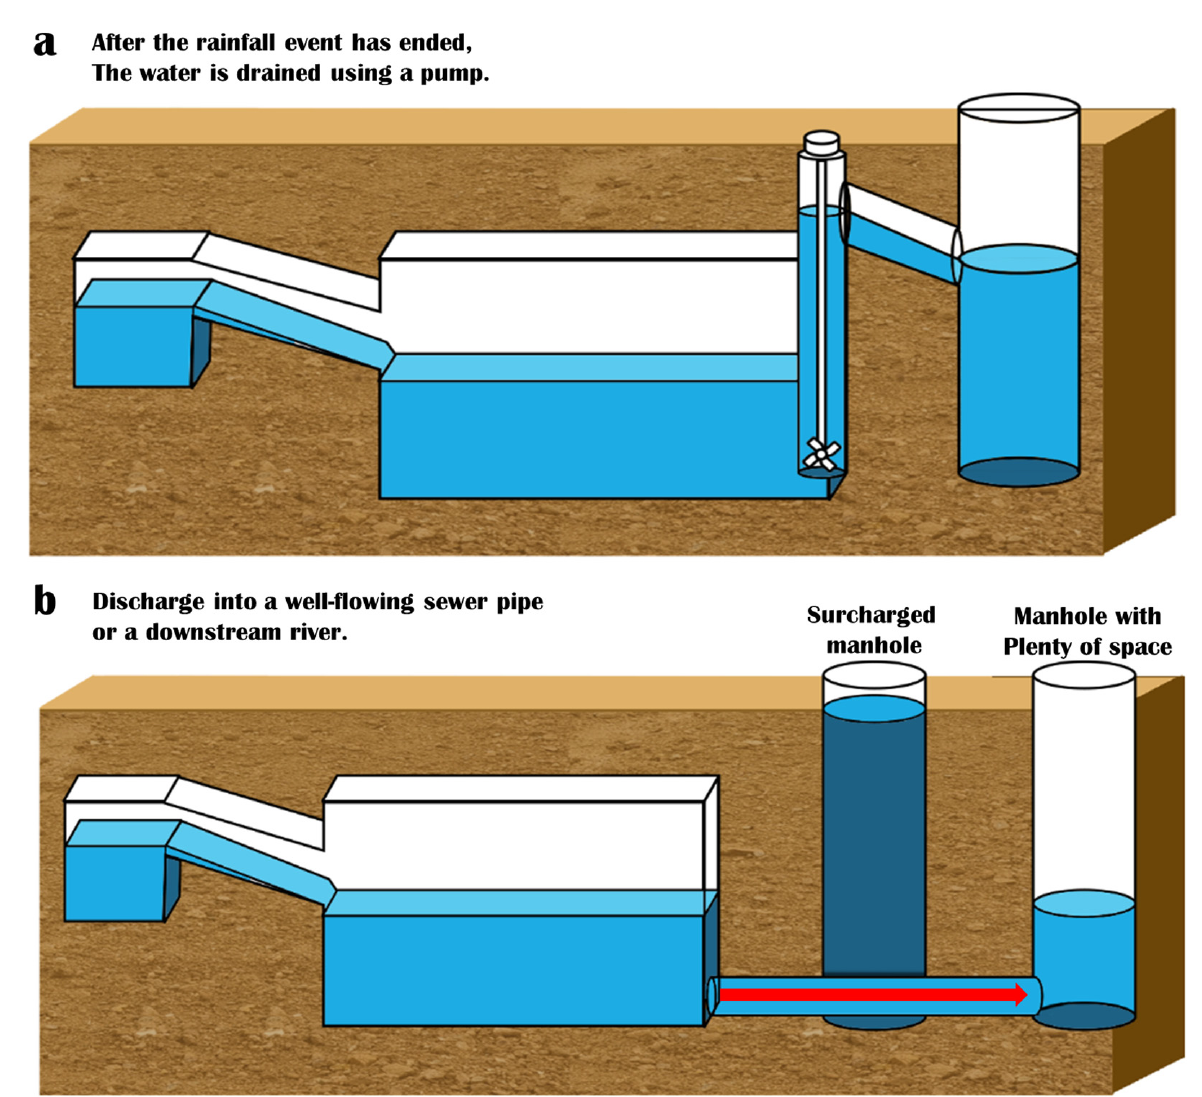
Figure 2. Comparison of the discharge plans of the underground storage tank and the trunk drainage sewer system. ( a ) Underground storage tank and ( b ) trunk drainage sewer system drainage methods .